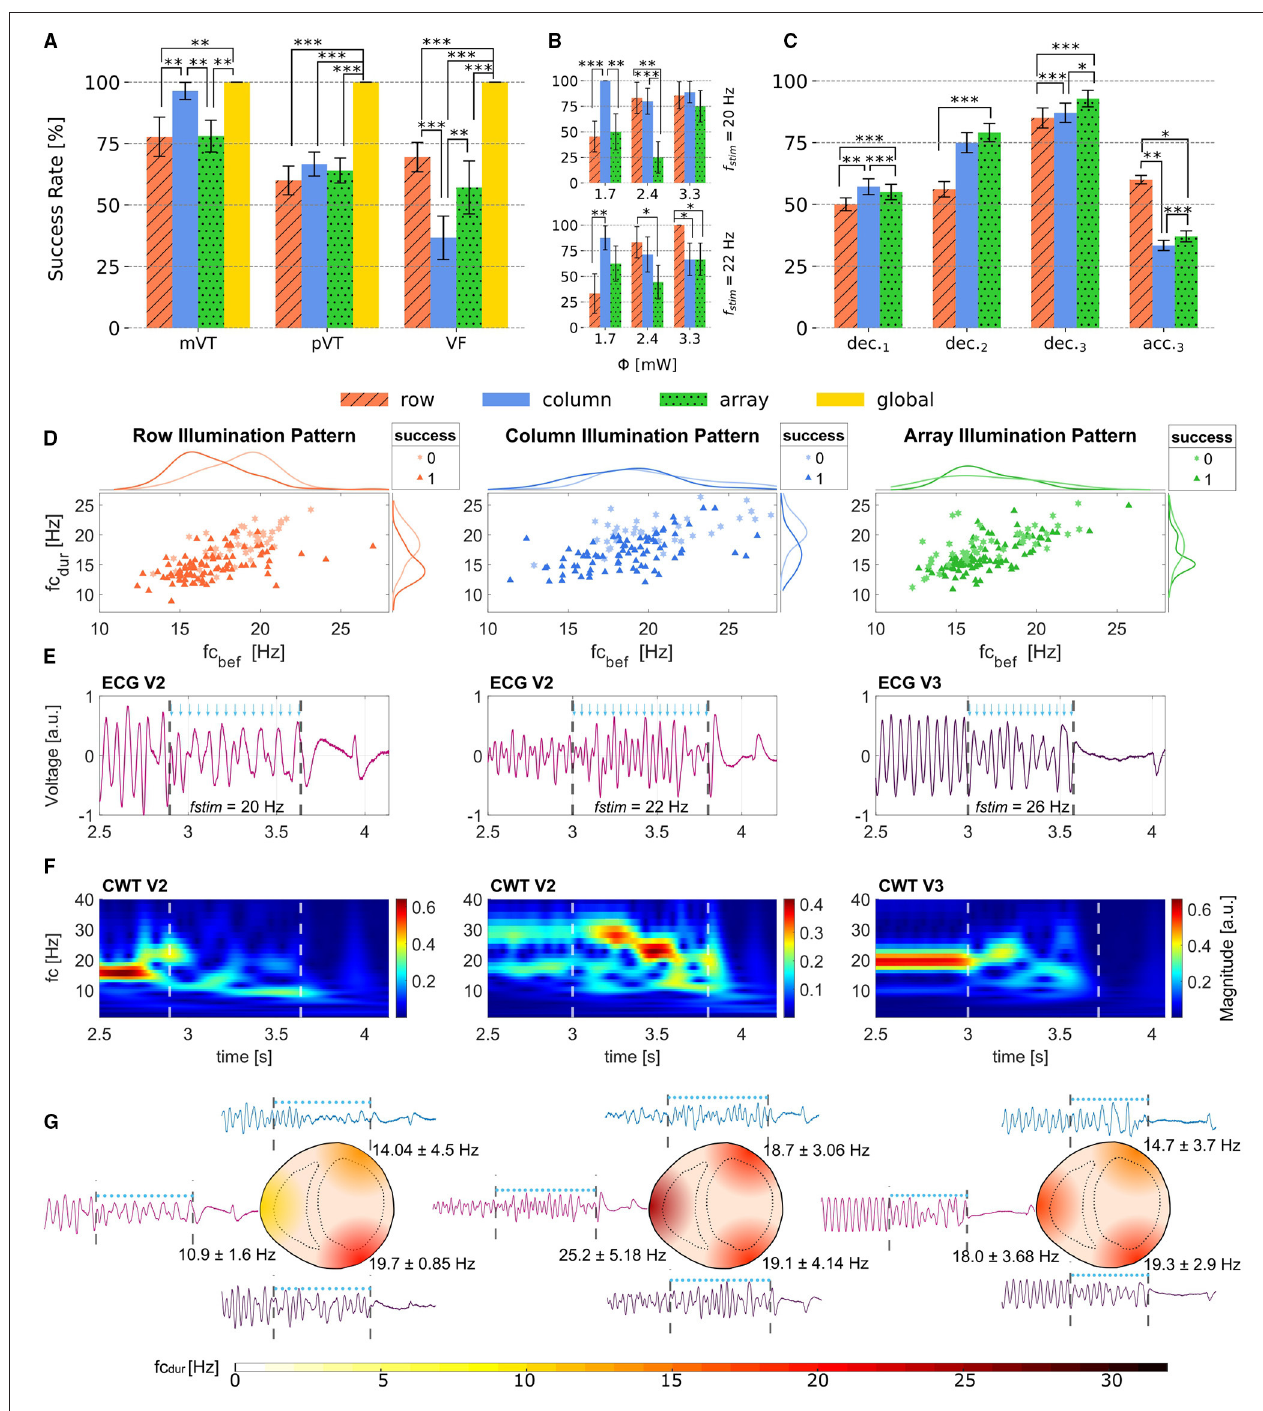
FIGURE 3 | Obtained Success Rates and effects of illumination during arrhythmia. (A) Success rates for mVT, pVT and VF depending on the illumination pattern. (B) Success rates for the photostimulation frequencies f stim = 20 and 22 Hz and the three different radiant fluxes applied. While the array protocol has the lowest termination rate for this two selected f stim , the row pattern terminates better with f stim = 20 Hz and the lowest radiant flux applied, and the column pattern reaches a success rate of 100% when applying 3.3 mW radiant flux and f stim = 22 Hz. (C) Termination rates shown with the deceleration observed in 1,2 and 3 Leads or acceleration measured in 3 leads. The data shown in (A–C) is reported with Error bars calculated with Standard Error of Mean (SEM). (D) Scatter plots showing the relation between fc bef and fc dur for row, column and array patterns. In addition the marginal histograms show the occurrence of success and failed attempts. (E) ECG recordings from different electrodes for one successful event using the three illumination patterns. The blue arrows show the timing of the light pulses and the dashed lines show the interval during illumination. (F) Magnitude Scalograms from the ECG leads shown in (E) . It can be observed that all three protocols are able to change both frequency and amplitude of the arrhythmia. (G) Representation of the heart for row (left), column (center) and array (right) protocols illustrating the extracted frequencies fc dur from V1, V2, and V3. Statistical significance illustrated as * p < 0.1, ** p < 0.05 and *** p < 0.01.